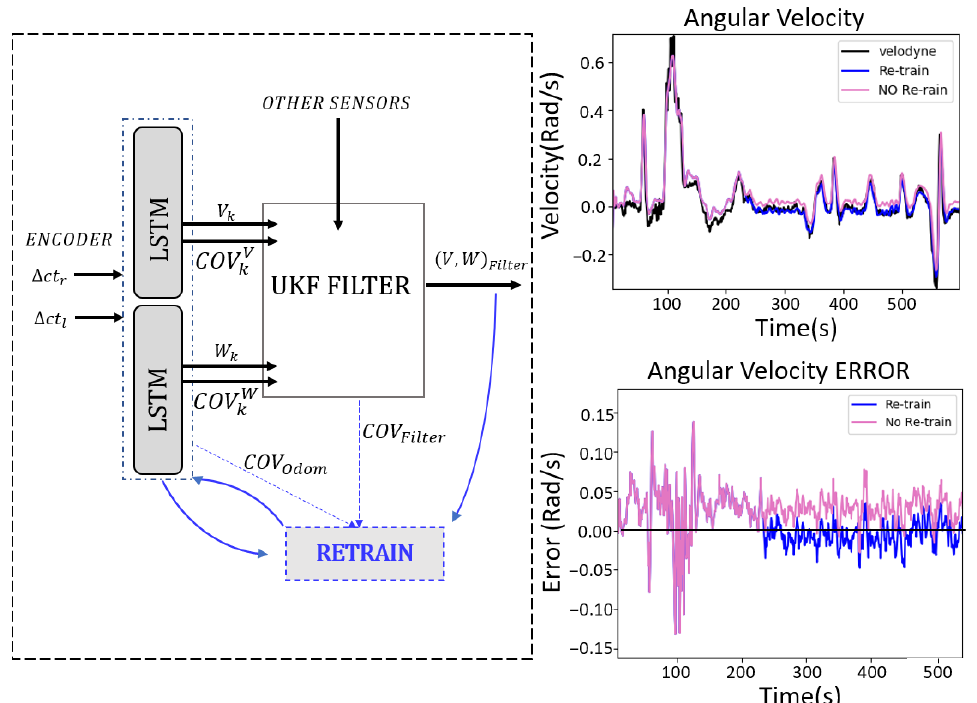
Figure 7. Retraining scheme for odometric model calibration. The error using the model with real-time retraining is smaller than using the model without